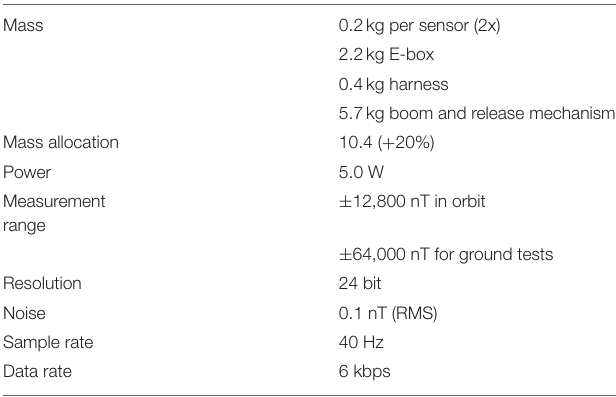
TABLE 2 | Summary of the performance of MAG.